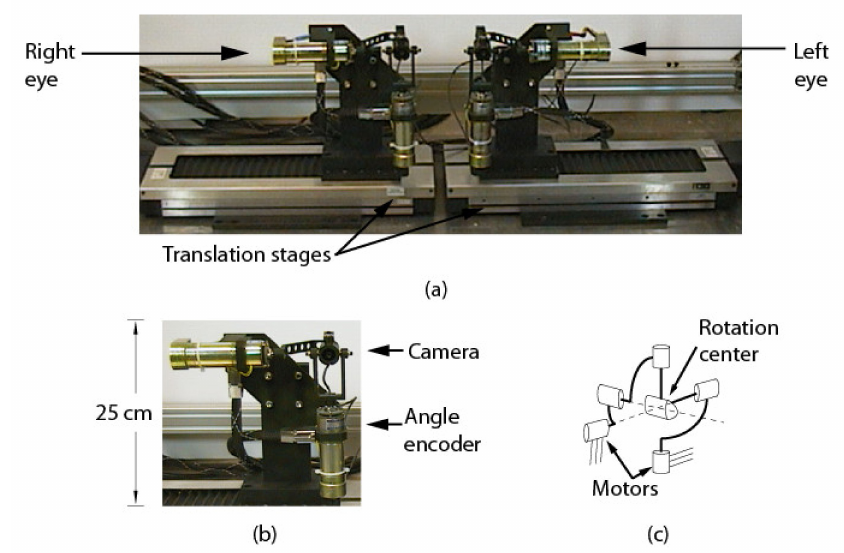
Figure 1. The ASP with both eyes and translation stages ( a ). ( b ) Actual mechanism for the right eye of the camera. The mechanism is very compact. ( c ) Basic principle of the 2DOFs parallel mechanism for tilt/pan rotation.